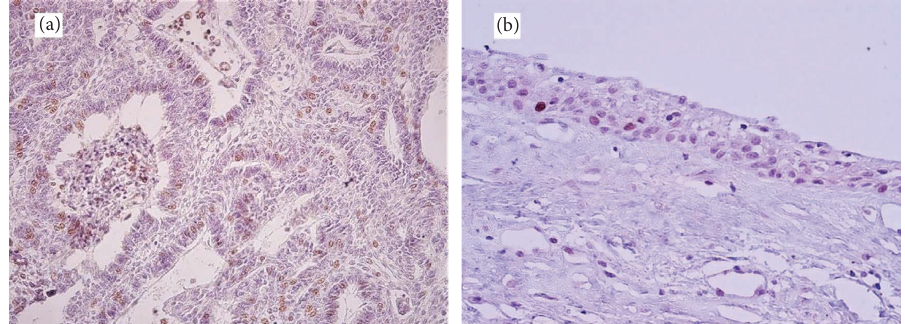
Figure 1: (a) Nuclear CDC7 expression in ameloblastoma ( × 200); (b) nuclear CDC7 expression in the basal cell layer of a dentigerous cyst ( × 400).